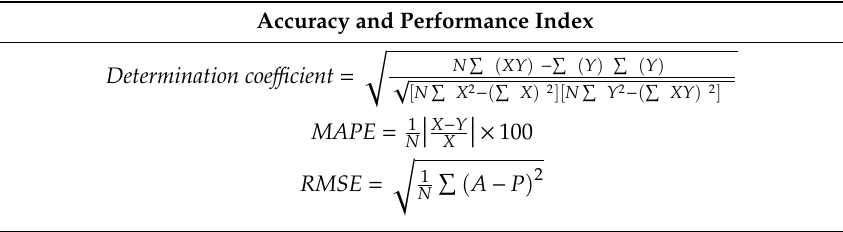
Table 2. Evaluation metrics used in this study.